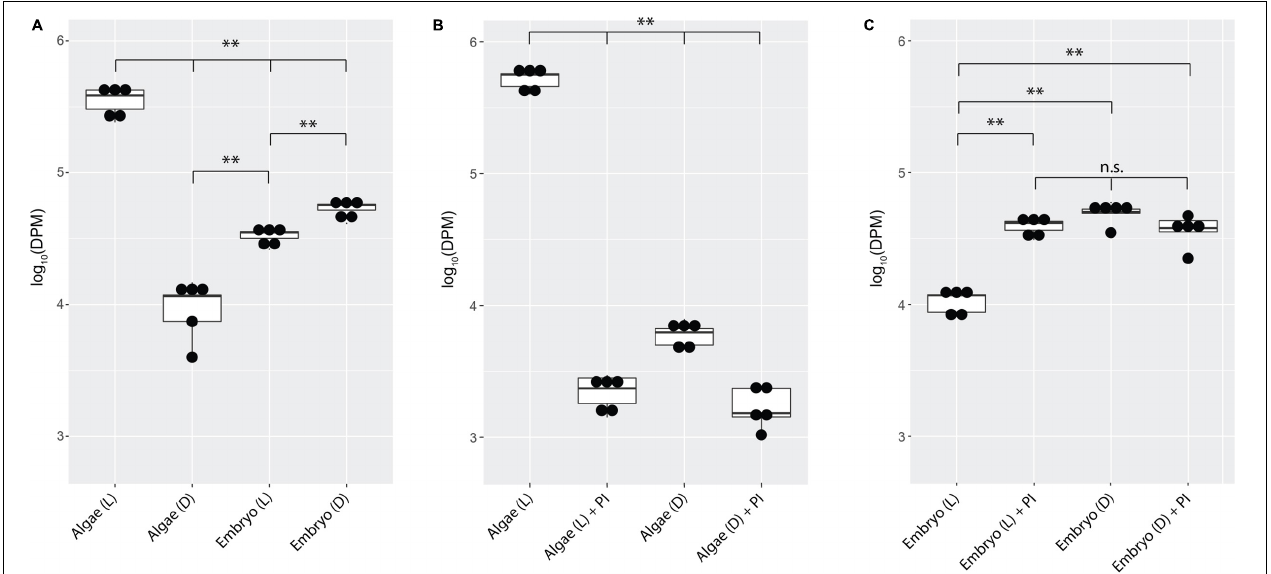
FIGURE 3 | A. maculatum embryos compete with O. amblystomatis algae for bicarbonate. In each image, the y -axis represents radioactivity assayed per sample (DPM, disintegrations per minute); the x -axis represents the treatments. (A) Algae from whole eggs incubated in the light (L) or dark (D). (B) Cultured algae incubated in the light or dark with and without photosynthesis inhibitors (PI). (C) Carbon fixation by embryos in the whole egg environment, in the light or dark with and without photosynthesis inhibitors. n.s. = not significant, ∗∗ p < 0.01. Significance levels were determined by ANOVA followed by the Games-Howell post-hoc test.